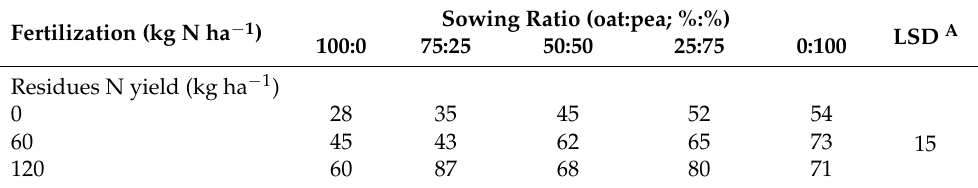
SR × F SR × Y F × Y A Above-ground biomass; Crop yields in dry matter; Significance level: p < 0.05 (*), p < 0.01 (**), p < 0.001 (***). There were no statistically significant SR × F × Y interactions. The small letters in the tables show the significant differences. Table 6. Residues N yield of oat and pea pure crop stands and oat:pea intercrops as affected by sowing ratio and N